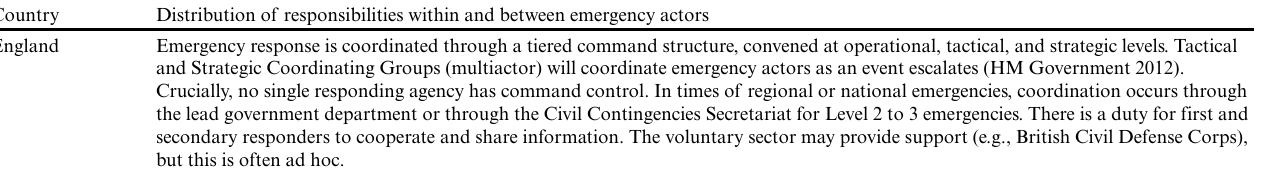
Table 4 . Distribution of responsibilities within and between emergency actors in selected countries. Country Distribution of responsibilities within and between emergency